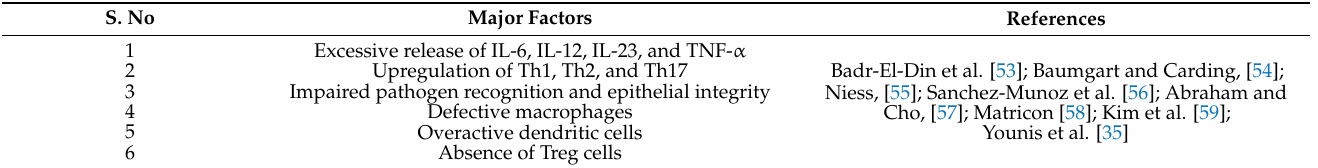
Table 2. The major factors associated with the inflammatory bowel disease pathogenesis.